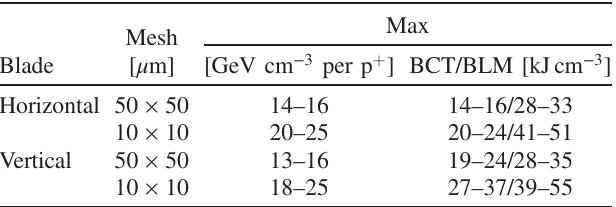
TABLE IX. Summary of maximum energy deposition values expected in the blades during the endurance test. Values take into account the amount of scraped beam as estimated via the BCT and BLM signals (see Table VI). The quoted meshes have a longitudinal stepping of 500 μ m.